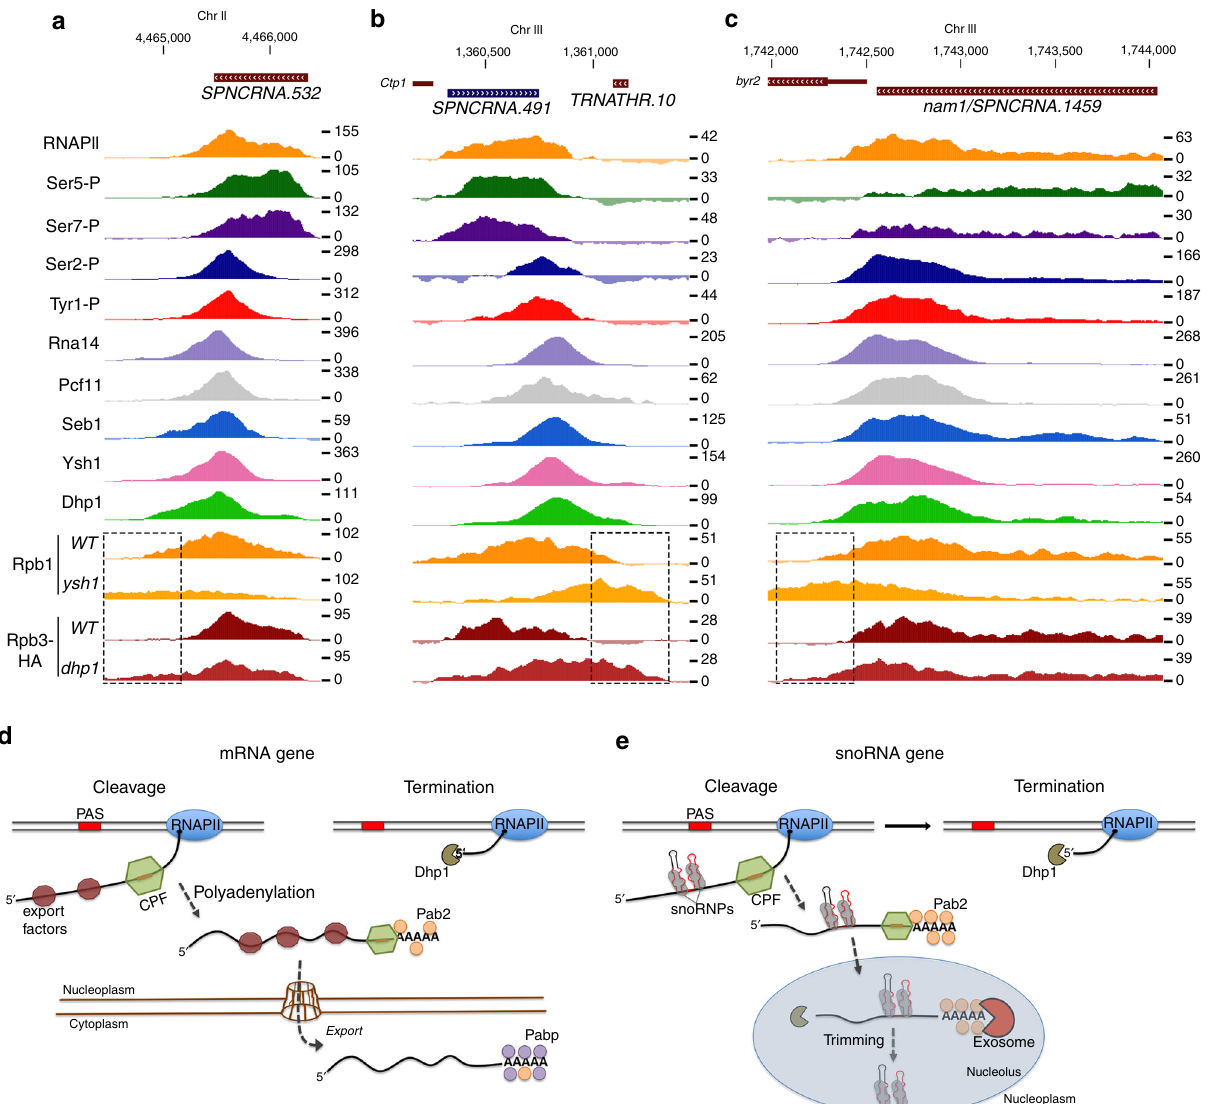
Fig. 7 Transcription termination at lncRNA genes and general model for 3 ′ end processing and transcription termination of mRNA and snoRNA genes in fi ssion yeast. a – c Normalized ChIP-seq signal of total RNAPII (Rpb1 and Rbp3-HA), the indicated CTD modi fi cations, and 3 ′ end processing factors across the SPNCRNA.532 ( a ), the SPNCRNA.491 ( b ), and the nam1/ SPNCRNA.1459 ( c ) genes. d , e Recruitment of cleavage and polyadenylation factors (CPF) by poly(A) signals (PAS) is a common feature of mRNA and snoRNA genes (see Cleavage ). Endonucleolytic cleavage by the CPF-associated Ysh1 nuclease will generate an RNAPII-bound unprotected 5 ′ end that will be targeted by the 5 ′ – 3 ′ exonuclease Dhp1, contributing to termination of mRNA and snoRNA transcription (see Termination ). The RNA-bound CPF complex promotes snoRNA 3 ′ end maturation, possibly by facilitating Pab2 recruitment to